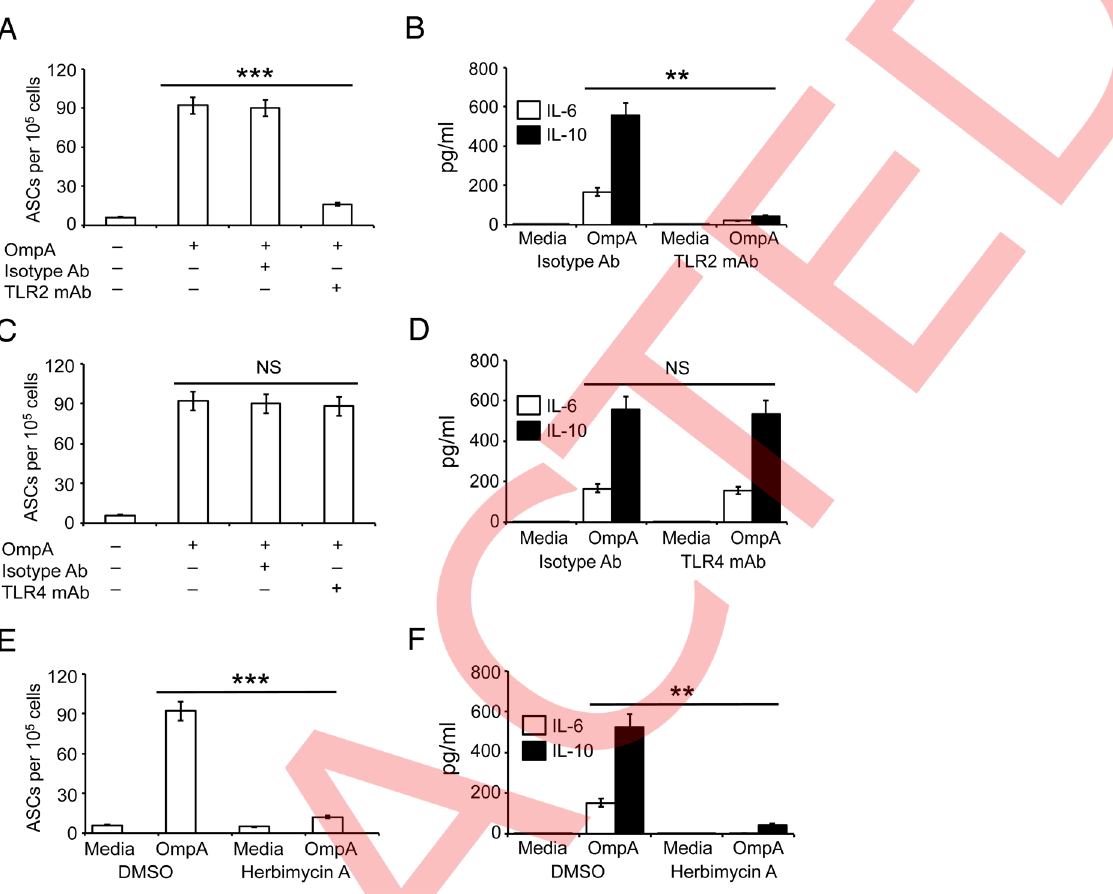
Figure 5. Involvement of TLR2 and protein tyrosine kinase in the OmpA-induced B cell differentiation and cytokine secretion. ( A, B ) B cells were incubated with anti-mouse TLR2 blocking antibody (100 ng/ml) or isotype (Mouse IgG1) control antibody (100 ng/ml) for 1 h at 37 u C, followed by addition of OmpA (5 m g/ml) for a further 72 h. ( A ) The total number of ASCs (IgM + IgG-secreting cells) was analyzed by ELISPOT. Number of ASCs/10 5 B cells. The results are the mean 6 S.E.M of three independent experiments. ***, p , 0.001, relative to OmpA treated group in the absence of TLR2 mAb. ( B ) The cell-free supernatants were assayed for IL-6 and IL-10 production by ELISA. The data are the mean 6 S.E.M of three independent experiments. **, p , 0.01, relative to OmpA treated group in the absence of TLR2 mAb. ( C, D ) B cells were incubated with anti-mouse TLR4/MD2 blocking antibody (100 ng/ml) or isotype (Rat IgG2a) control antibody (100 ng/ml) for 1 h at 37 u C, followed by addition of OmpA (5 m g/ ml) for a further 72 h. ( C ) The total number of ASCs (IgM + IgG-secreting cells) was analyzed by ELISPOT. Number of ASCs/10 5 B cells. The results